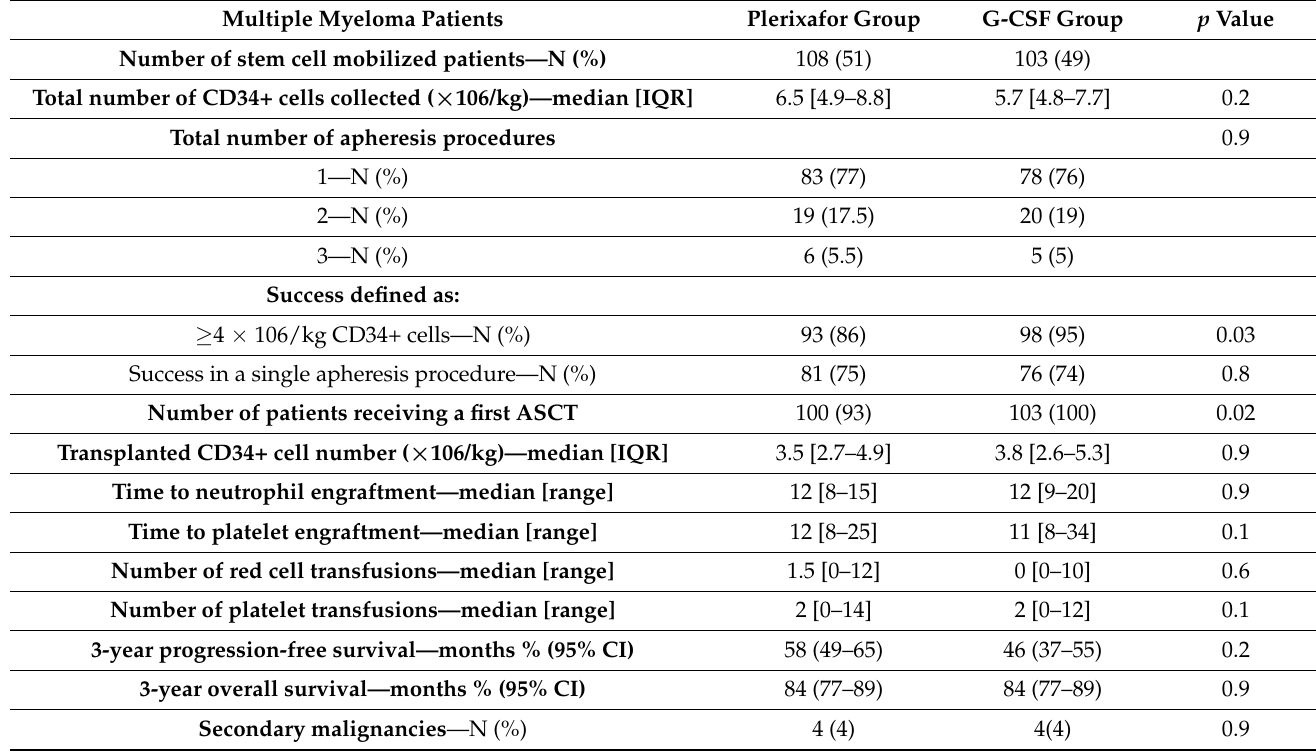
Table 3. CD34+ cell kinetics, engraftment, and outcome in multiple myeloma patients. Multiple Myeloma Patients Plerixafor Group G-CSF Group p